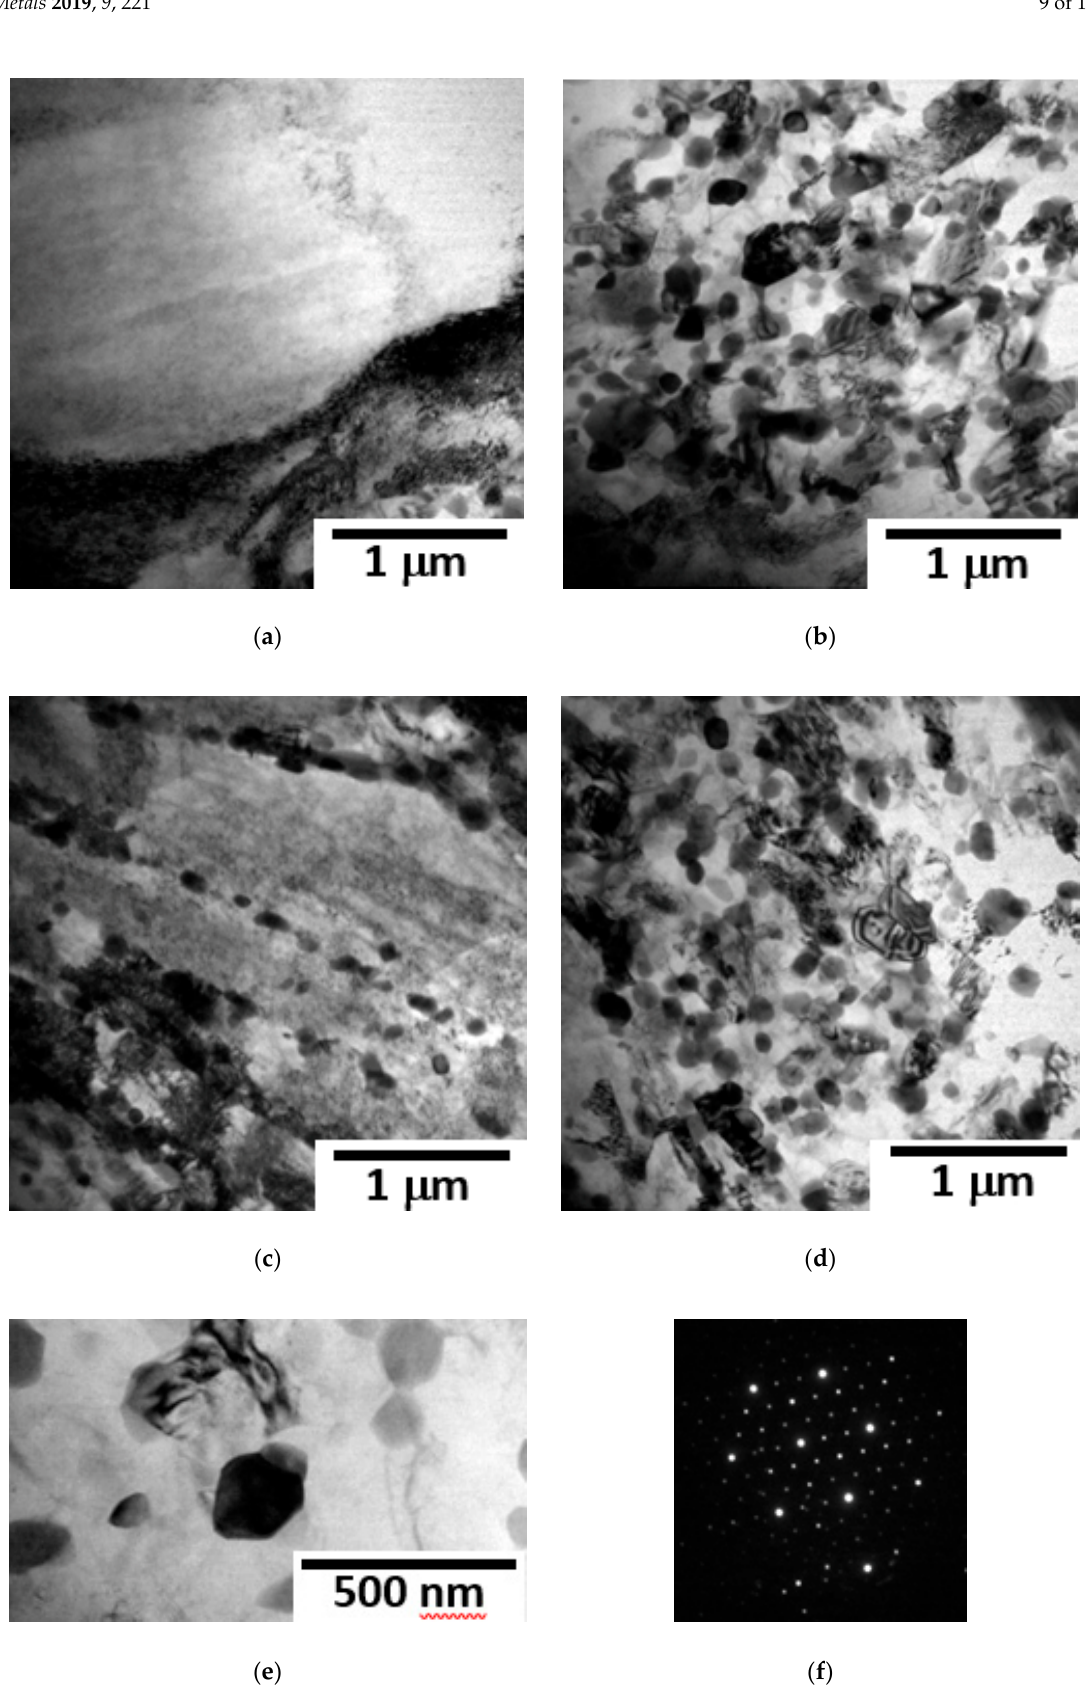
Figure 8. Bright field TEM images of the extruded GWZ831 alloy after ( a , b ) 4 and ( c , d ) 6 ECAP passes. a and c images correspond to non-DRXed grains and b and d images correspond to DRXed grains. ( e ) TEM images and ( f ) SAED pattern of β particles (B = [111]).